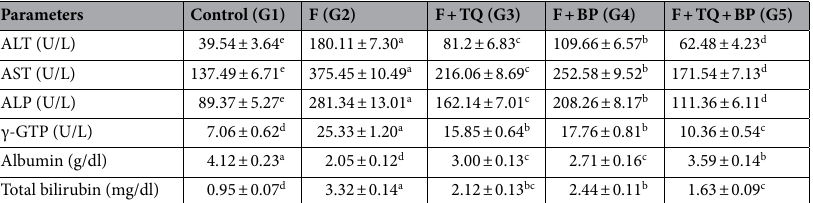
Table 1. Effect of TQ and/or BP treatment on serum levels of liver damage parameters in fluvastatin-induced hepatitis in rats. Data are expressed as mean ± SEM (n = 7/group). Mean values with different superscript letters [a (the highest values) – e (the lowest value)] in the same row are significantly different at ( p ≤ 0.05). All groups were compared to each other. BP, Bee pollen; G1-5, Groups 1–5; F, Fluvastatin; TQ,